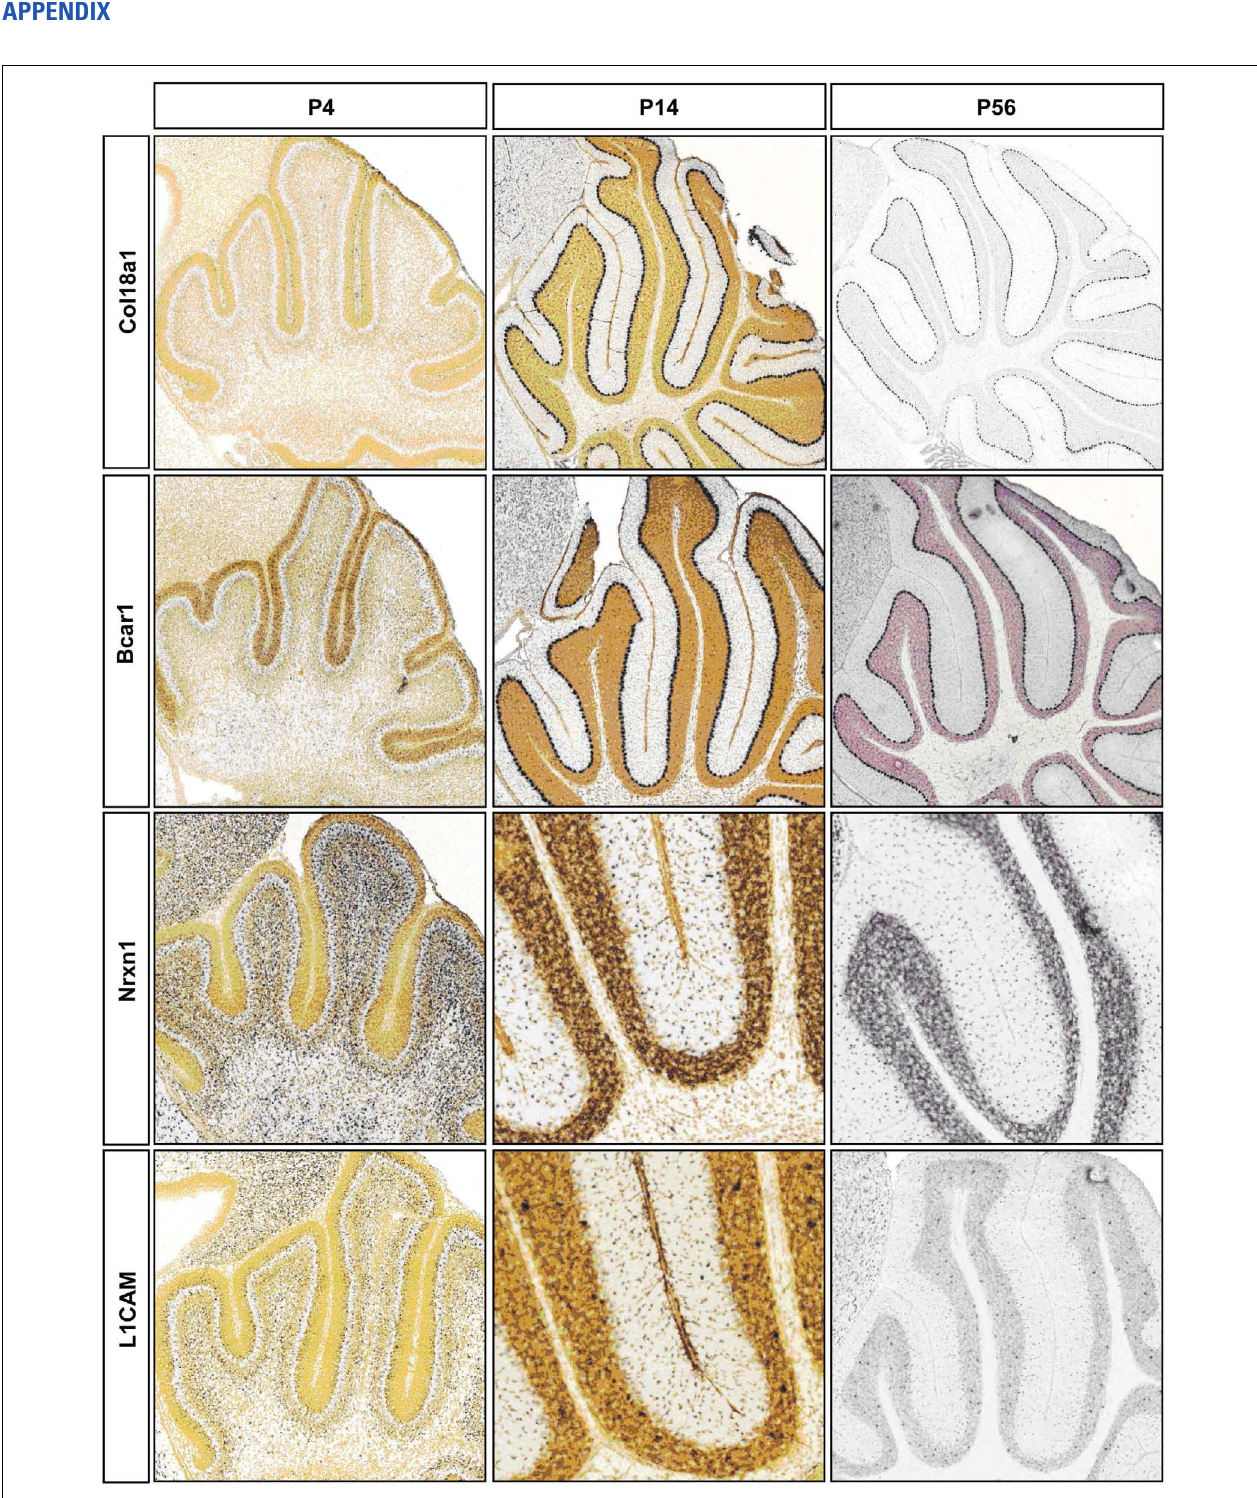
FIGUREA1 | Representative RNA in-situs fromAllen Brain developing mouse brain images showing the expression of cell adhesion molecule transcripts, Col18a1 , Bcar1 , Nrxn1 , and L1cam . Expression changes matched with microarray developmental